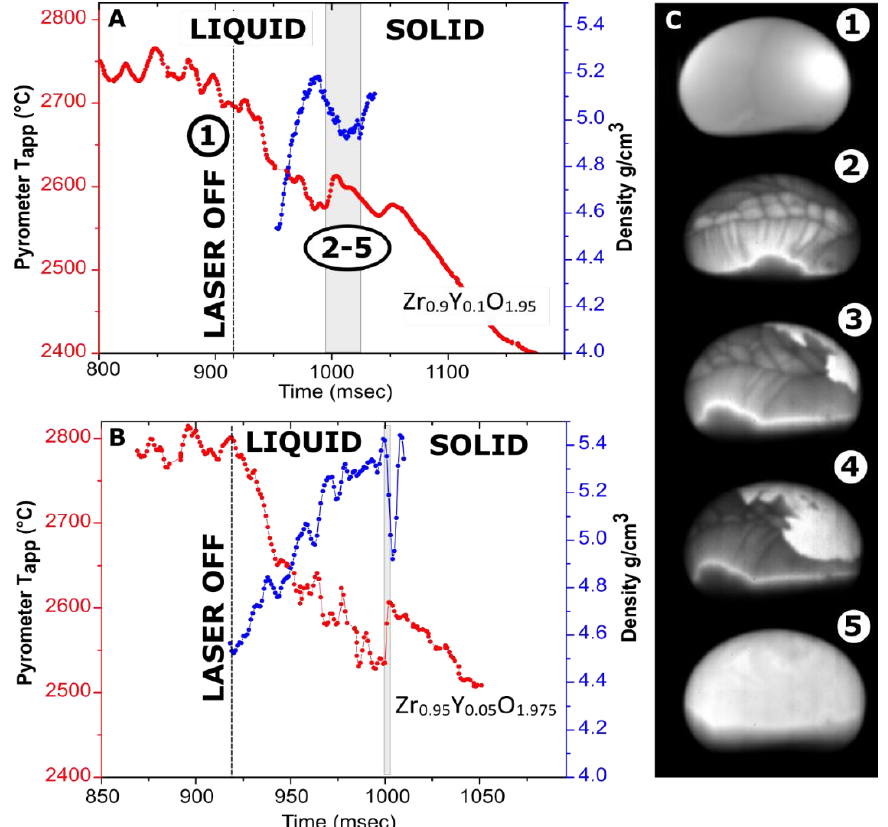
Figure 3. Cooling traces with overlayed density measurements. ( A ) 119.5-mg Zr 0.9 Y 0.1 O 1.95